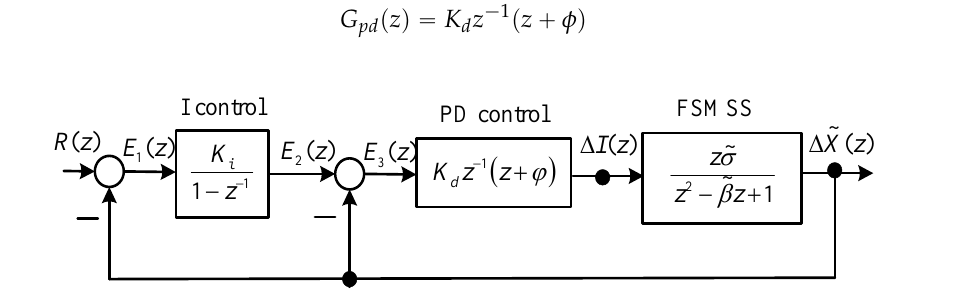
Figure 2. Block diagram of the FSMSS and IPD control.